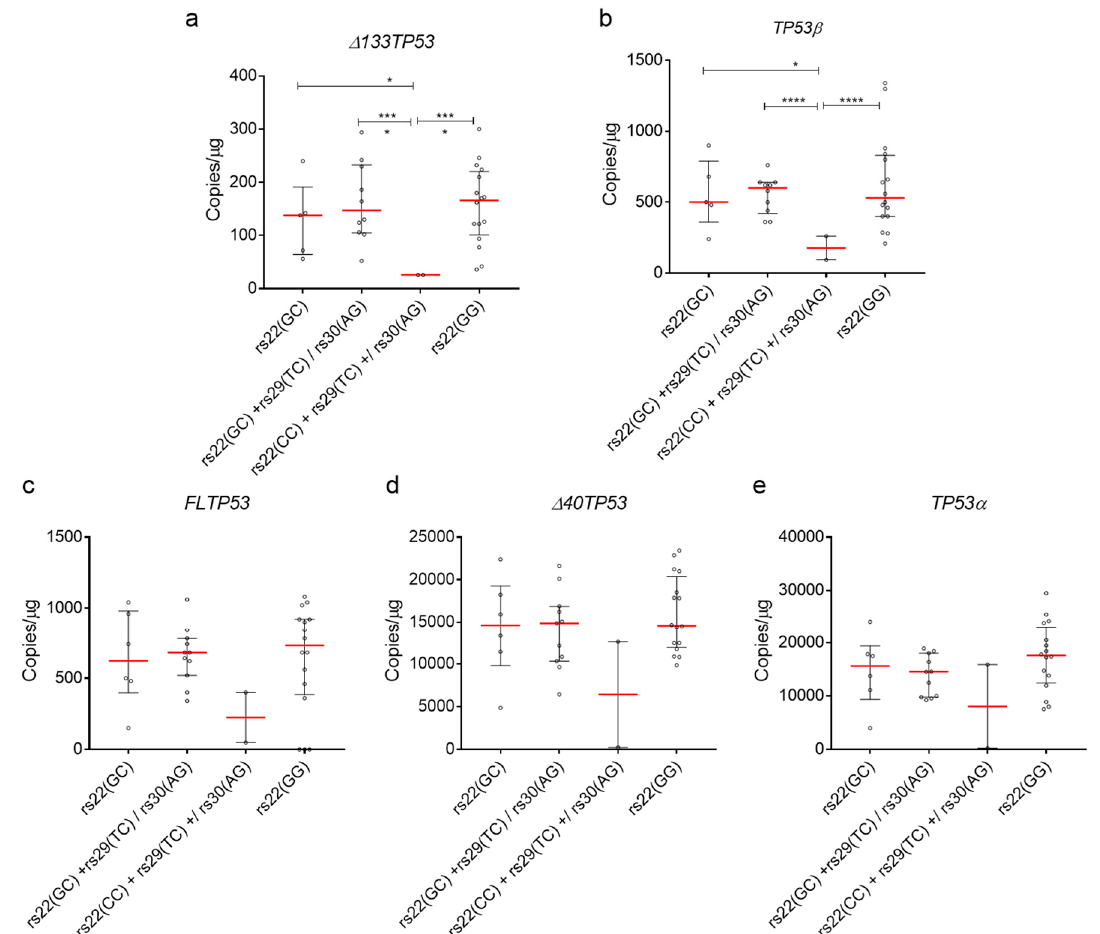
Figure 5. Intronic SNPs (rs29 and rs30) are associated with increased mRNA levels of ∆ 133TP53 and TP53 β in breast fibroblast cell lines. ( a ) ∆ 133TP53 , ( b ) TP53 β , ( c ) FLTP53 , ( d ) ∆ 40TP53 and ( e ) TP53 α mRNA expression from breast fibroblasts. ( a – e ) Dot plot of batch normalised mRNA expression of TP53 isoforms. Red line—median and whiskers—interquartile range. Significance was determined using Welch’s t-test. *— p -value. * < 0.05, *** < 0.001 and **** < 0.0001, respectively.